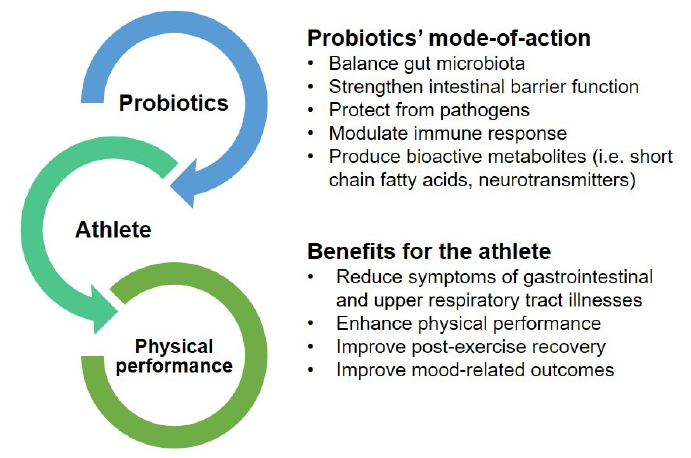
Figure 2. Proposed mechanisms and benefits of probiotic use in athletes.